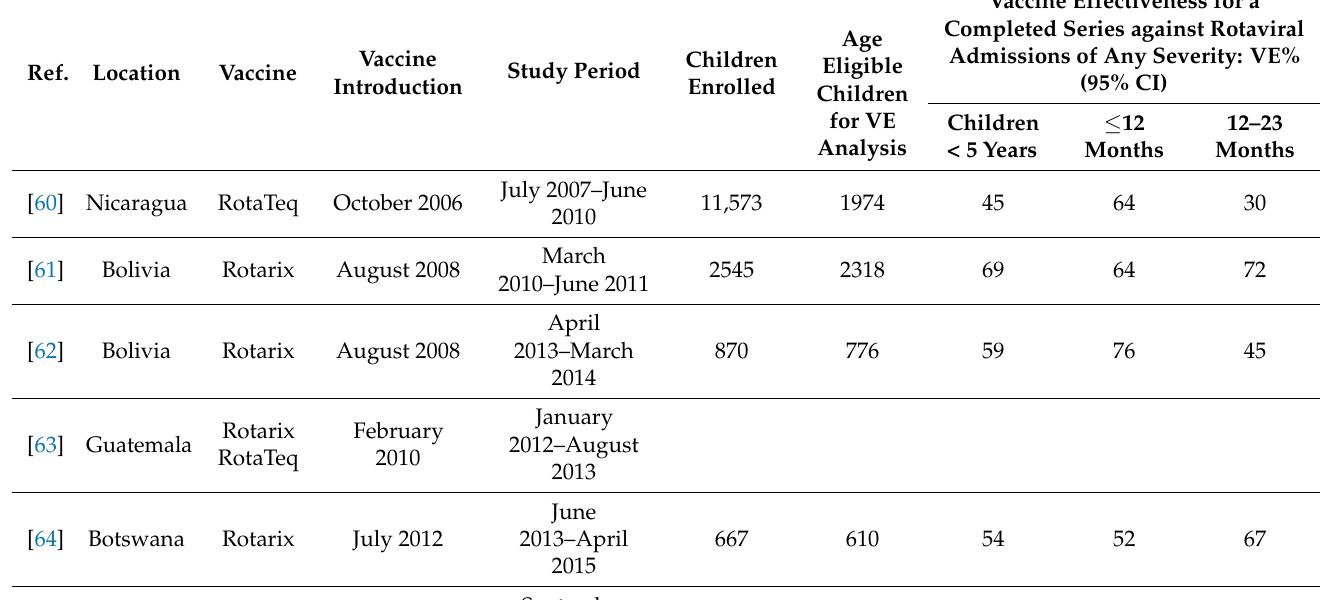
Table 3. Rotavirus vaccine effectiveness studies conducted in countries with high-mortality